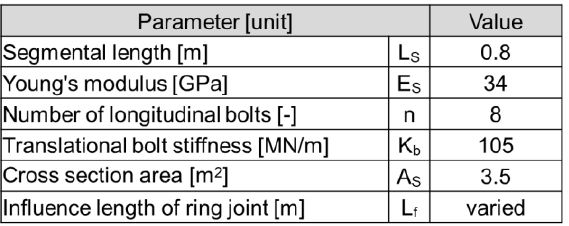
SDT-related input data required to determine ξ